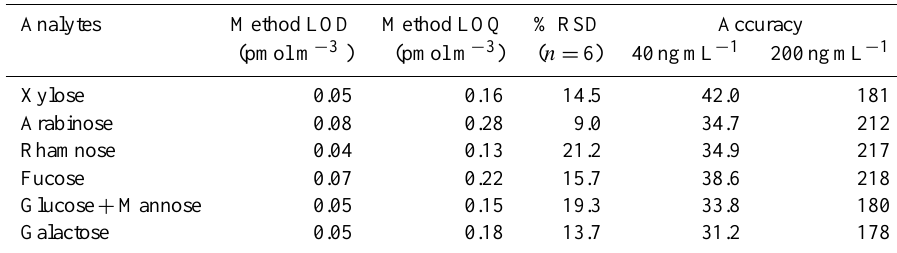
Table 1. Accuracy, precision, relative standard deviation (%RSD), limits of detection (LOD) and limits of quantification (LOQ) of the analytes